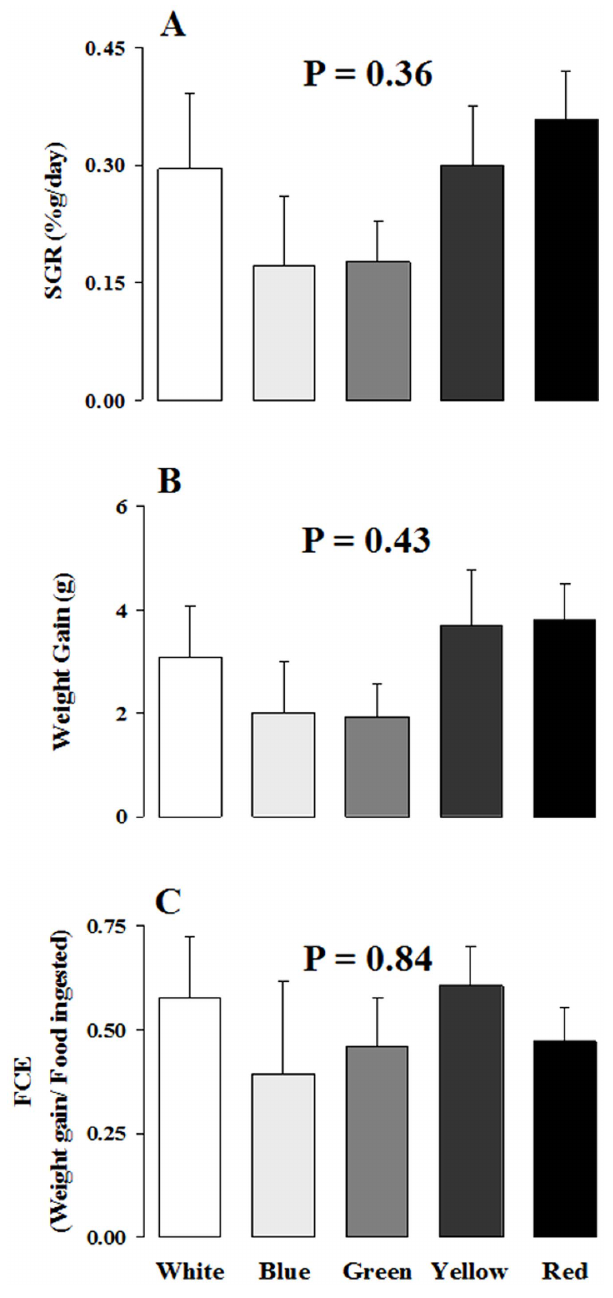
Figure 4. Effects of holding color on growth (A and B) and feed consumption efficiency (C – FCE). Means 6 SEM from 6 fish of each color, except for yellow (N=5). No significant difference was found among the color